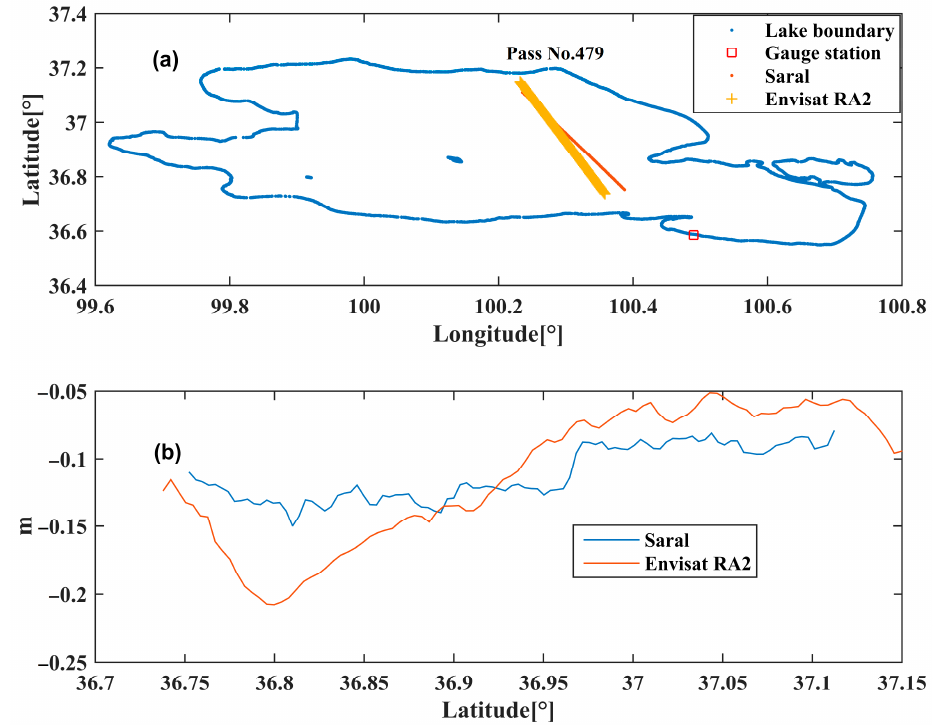
Figure 8. Accuracy verification of SARAL. ( a ) Trajectory selection; ( b ) comparison of height difference between SARAL and Envisat RA2.